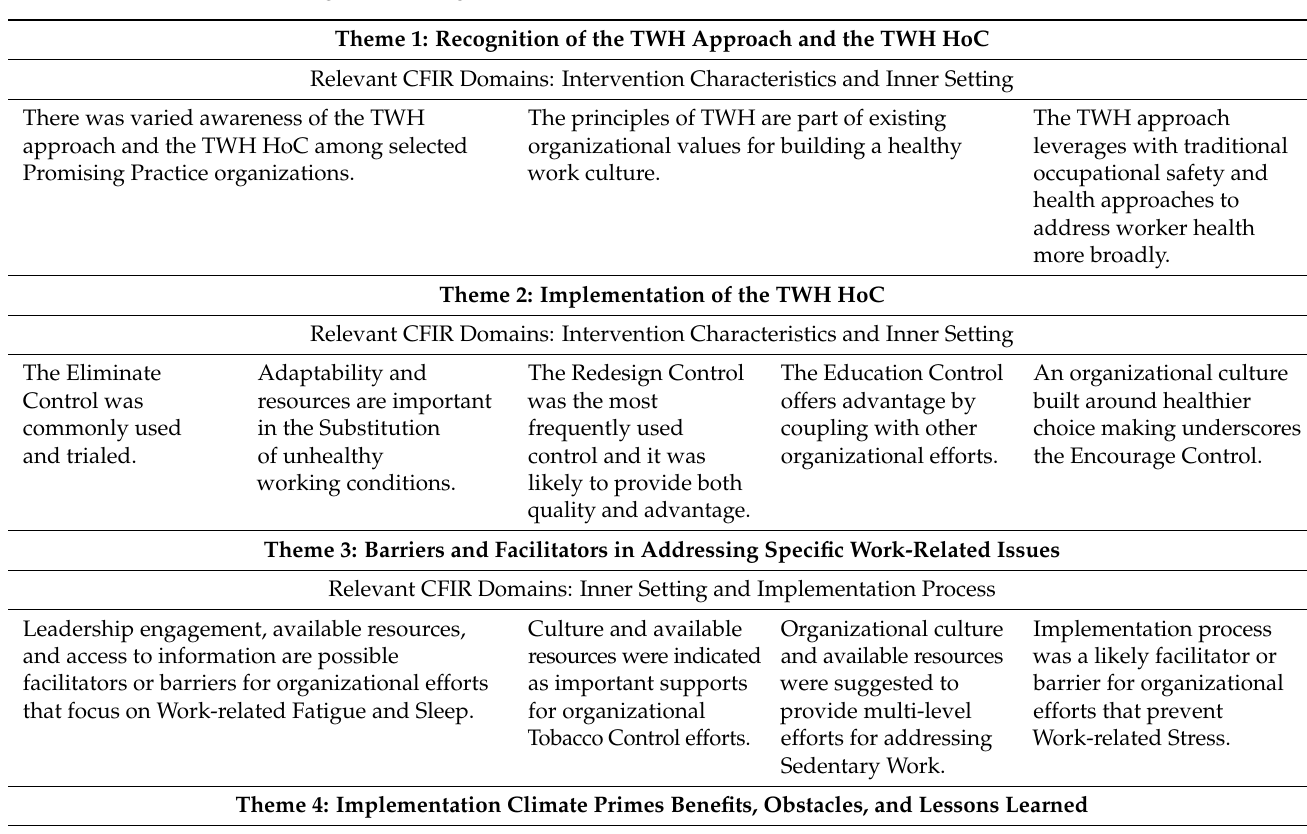
Table 2. Description of Themes and Subthemes Related to Implementation of the Hierarchy of Controls Applied to NIOSH Total Worker Health among Selected